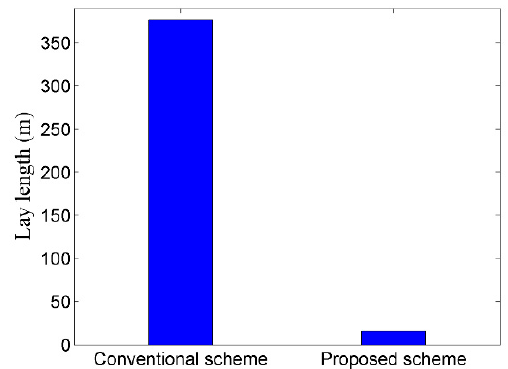
Figure 13. Lay length comparison of proposed PE 100 based FGIL with the conventional gas insulated lines (GIL) scheme.